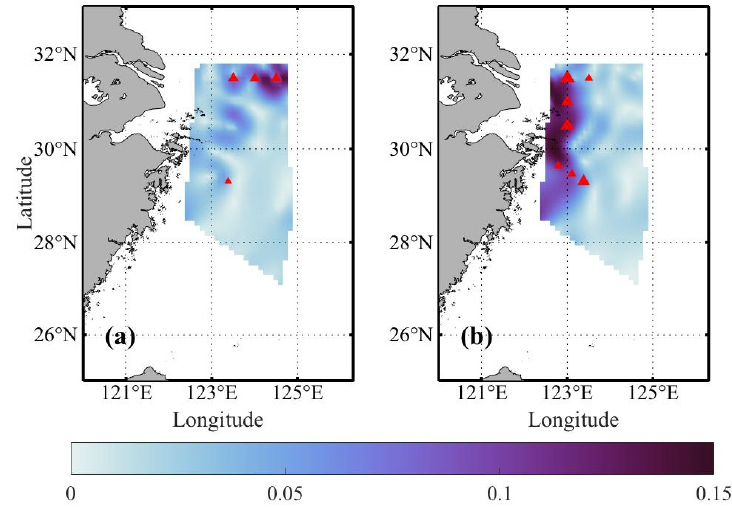
Figure 7. Schematic diagram of the gradient norm distribution of the interpolation results with the thin plate spline RBF method at − 5 m depth in summer 2010 (the unit are °C · km − 1 and psu · km − 1 for ( a ) and ( b ), respectively). The red triangles present the locations of the observations at − 5 m depth where there is an absolute error larger than 0.1 (°C or psu) in the random 10-fold cross-validation experiments, and its size reflects the size of the error. ( a ) Temperature; ( b ) Salinity. Table 5. The average gradient norm at − 5 m depth of four cruises. Period Temperature (°C · km − 1